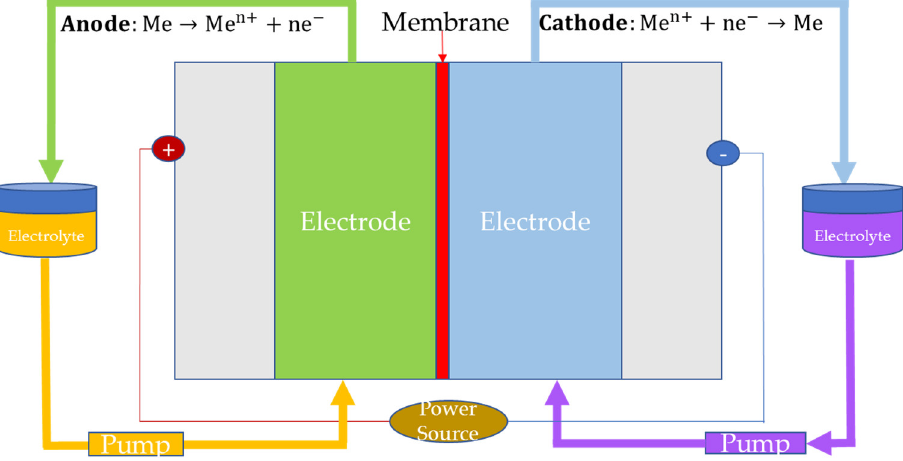
Figure 8. Cell configuration of redox flow batteries (“Me” refers to reactant dissolved in the electrolyte solution).